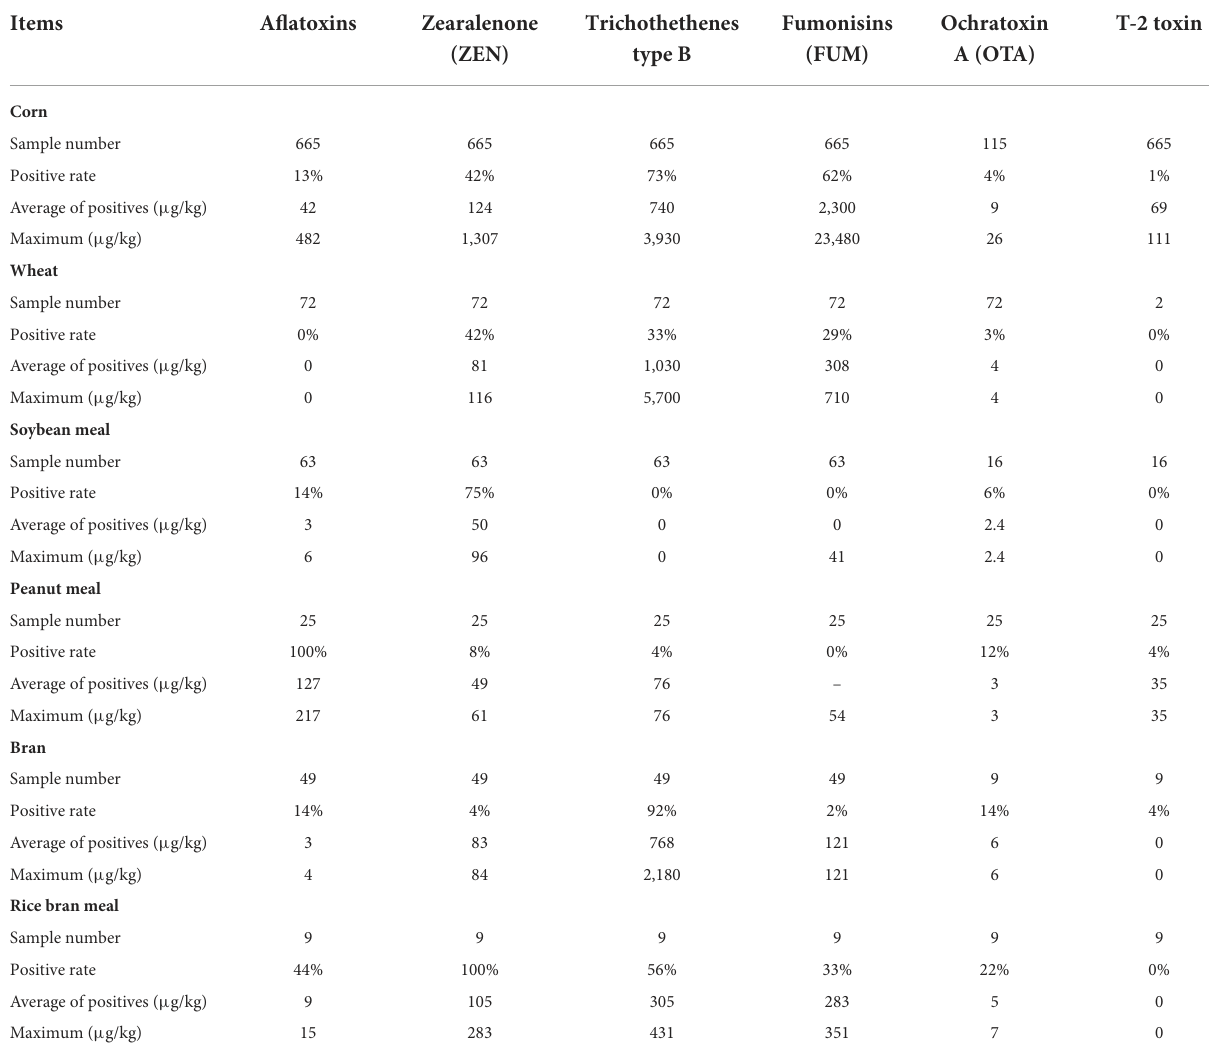
TABLE 2 Mycotoxin occurrence in feed raw